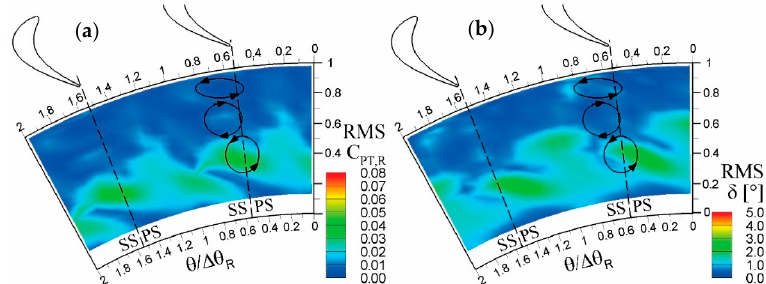
Figure 11. RMS of periodic unsteadiness for OP1 (transonic), ( a ) RMS of the relative total pressure coefficient; ( b ) RMS of the deviation angle.